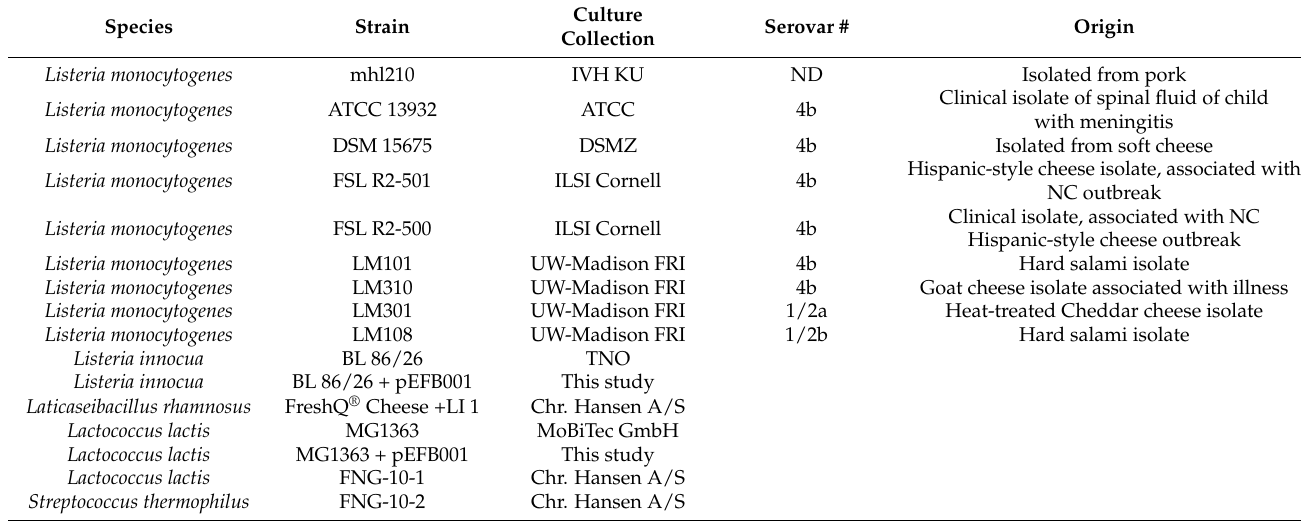
Table 1. Strains used in this study. Serovars and origins are given for L. monocytogenes strains. Culture Species Strain